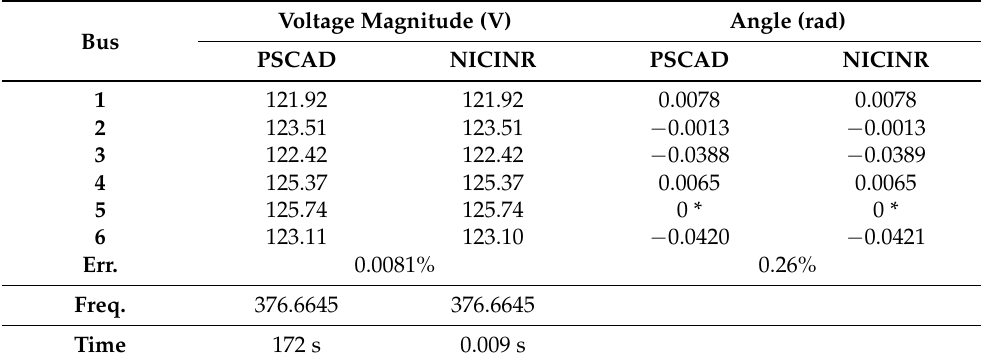
Table 3. Validation of obtained result of the six-bus test